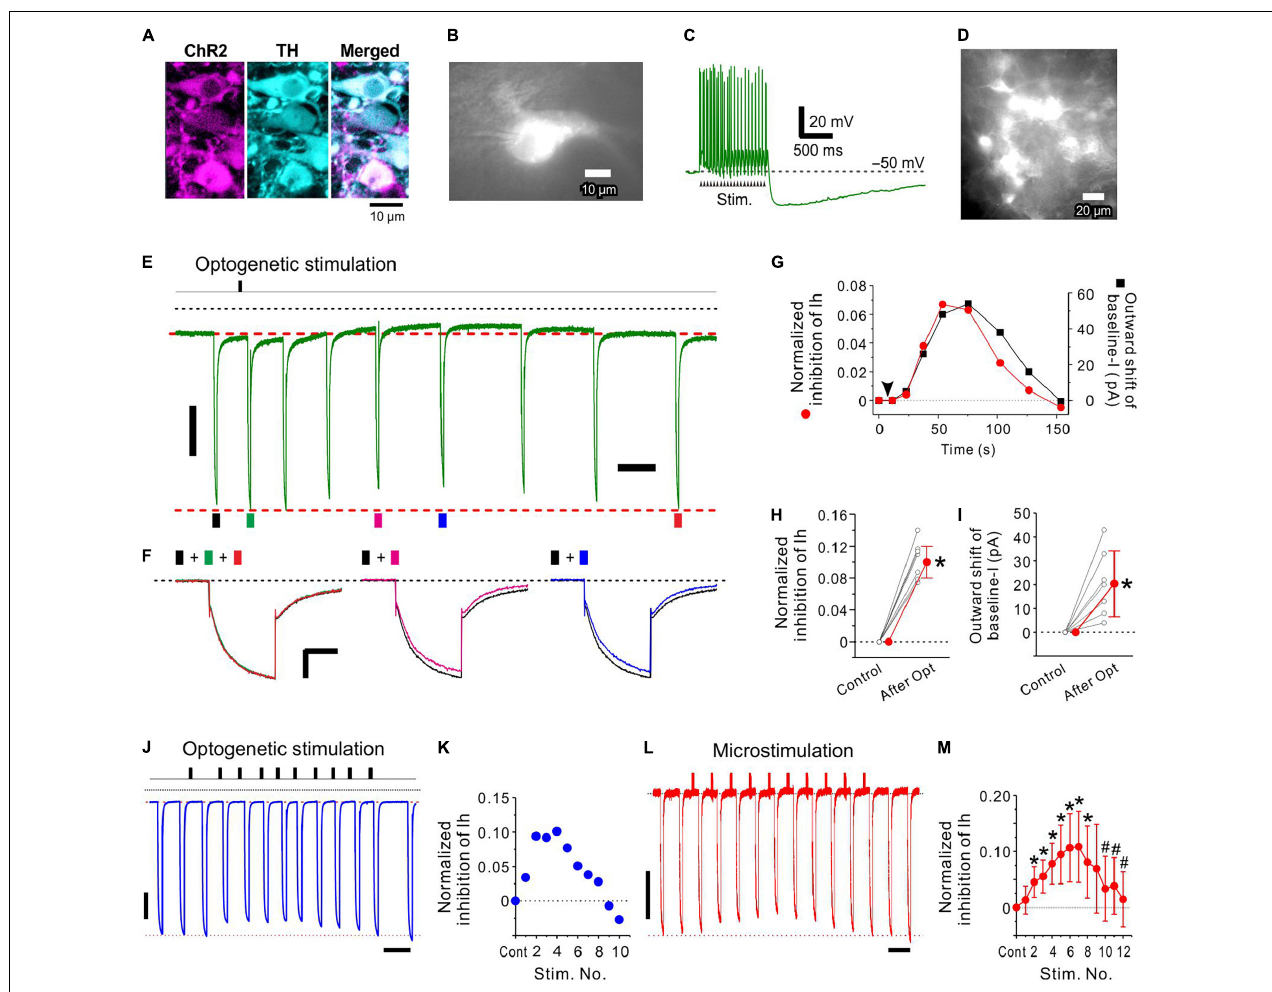
FIGURE 5 | Optogenetic activation of LC neurons inhibits Ih evoked in an MTN neuron. (A) Photomicrographs showing mCherry and TH expression in LC neurons (left and middle, respectively) following transduction with CAV-PRS-ChR2-mCherry. A merged image of ChR2-mCherry and TH expression (right). Note that all mCherry-positive neurons were TH-positive neurons. (B) A ChR2-mCherry expressing LC neuron from which whole-cell recordings were obtained. (C) A train of > 20 spikes evoked by optogenetic stimulation (20 mW, 20 pulses of 4 ms duration at 20 Hz) of the LC neuron shown in (B) . (D) A photomicrograph obtained during optogenetic stimulation in a slice preparation including ChR2-expressing LC neurons. (E,F) In response to optogenetic stimulation of LC neurons (arrow), the amplitude of Ih evoked in an MTN neuron was slowly decreased (compare black trace with green, pink, and blue ones) and then slowly recovered to the original level (compare black trace with red trace). This change was accompanied by the outward shift of baseline currents. (G) Time courses of normalized inhibition of Ih (red circle) and outward shift of baseline currents (baseline-I; black square). The baseline current level is masked by the long-lasting tail current (tail-I) of the preceding Ih. Baseline current level just before the onset of each Ih was compensated by subtracting the amplitude of the preceding tail-I calculated by exponential fitting of the tail-I of the 1st Ih. (H) Normalized inhibition of Ih obtained before (Control) and after optogenetic stimulation ( n = 7). Paired t -test: * p < 0.001. (I) Outward shift of baseline-I obtained before (Control) and after optogenetic stimulation ( n = 7). Paired t -test: * p = 0.008. (J,K) The repetitive 1 s optogenetic stimulations at short intervals smaller than 10 s induced a cumulative increase in Ih inhibition only transiently and was followed by a forced termination of the Ih inhibition. Ih amplitude was measured for the response evoked approximately 10 s after the respective stimulation. If 10 s after stimulation was just in between the two responses, the average amplitude of the two responses was used as a response for the stimulation. Note that a short interval of the first and second optogenetic stimulations resulted in a much larger Ih inhibition compared to the case with a longer interval > 20 s. (L,M) Significant cumulative increases in normalized inhibition of Ih induced following up to 6–7 repetitive 1 s microstimulations with an interval of 9 s ( M ; n = 7), after which the forced termination of Ih inhibition began and the maximal inhibition of Ih was significantly decreased after 10 repetitive microstimulation ( M ; n = 7). Two-way repeated measures ANOVA: p < 0.001, followed by Bonferroni post hoc test, * p < 0.03 (vs. control; the largest p -value is 0.028) and # p < 0.002 (vs. 7th stimulation; the largest p -value is 0.0012). Vertical scale bars; (E,F,J,L) 200 pA. Horizontal scale bars; (F) 500 ms: (J,L) , 10